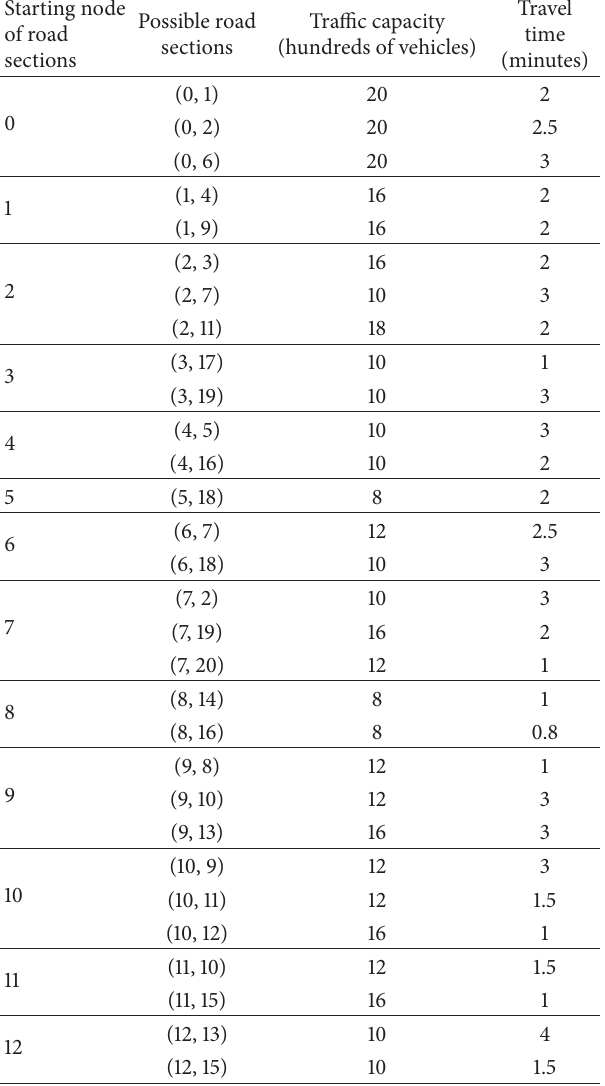
Table 1: Possible road sections of emergency evacuation. Starting node of road sections